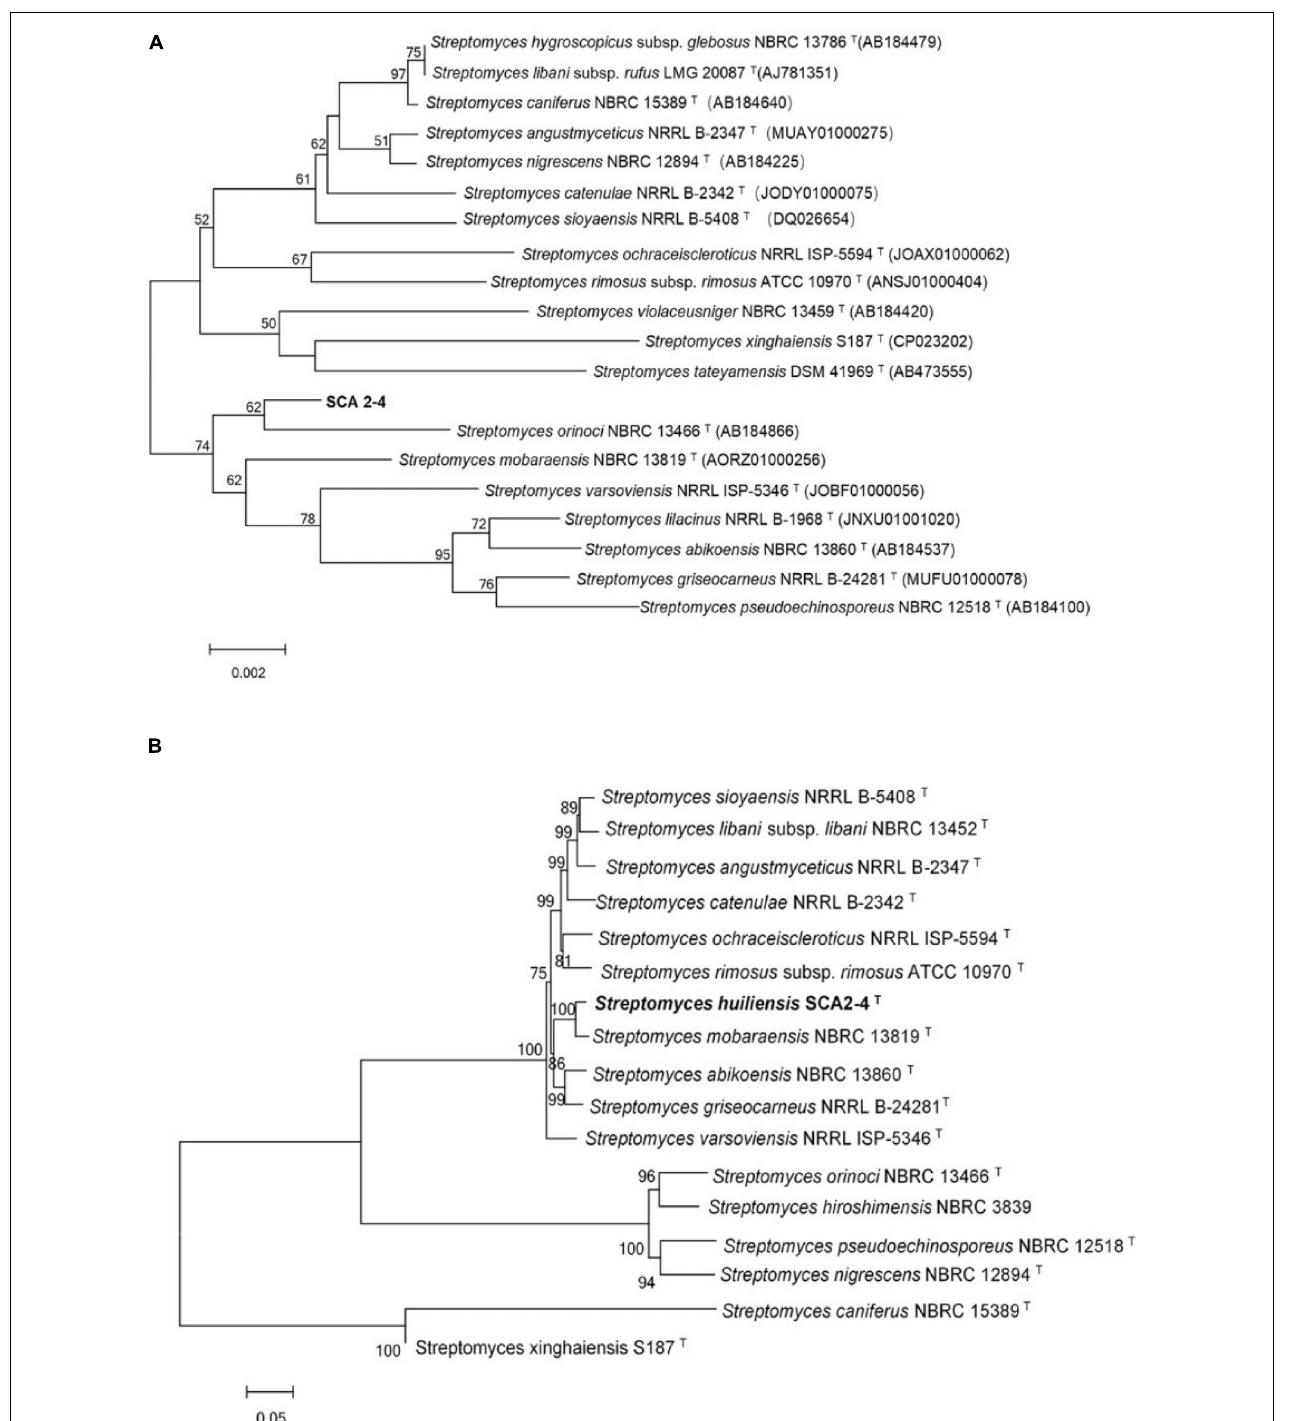
FIGURE 2 | Phylogenetic trees of strain SCA2-4 T based on 16S rRNA and house-keeping genes. Bootstrap percentages (based on 1000 replications) were shown at branching points. Bar, 0.002 or 0.05 substitutions per nucleotide position. (A) Construction of phylogenetic tree based on the complete 16S rRNA sequences using the Neighbor-Joining method. Accession numbers of the selected genes were listed in brackets. (B) Construction of phylogenetic tree based on concatenated five house-keeping genes ( atpD , gyrB , recA , rpoB, and trpB ) using the Neighbor-Joining method. Strain names and accession numbers were provided in Supplementary Table 1